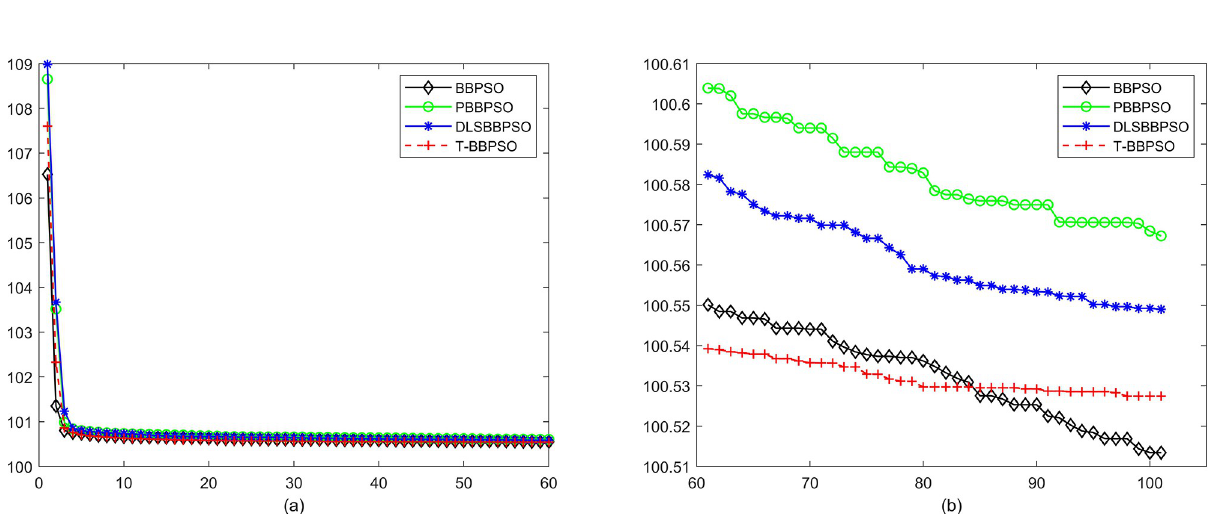
Fig 28. Comparison of convergence speed between BBPSO, PBBPSO, DLS-BBPSO and TBBPSO, f 26 , (a) iteration 0–6000, (b) iteration 6000–10000 the unit is 100 iteration.